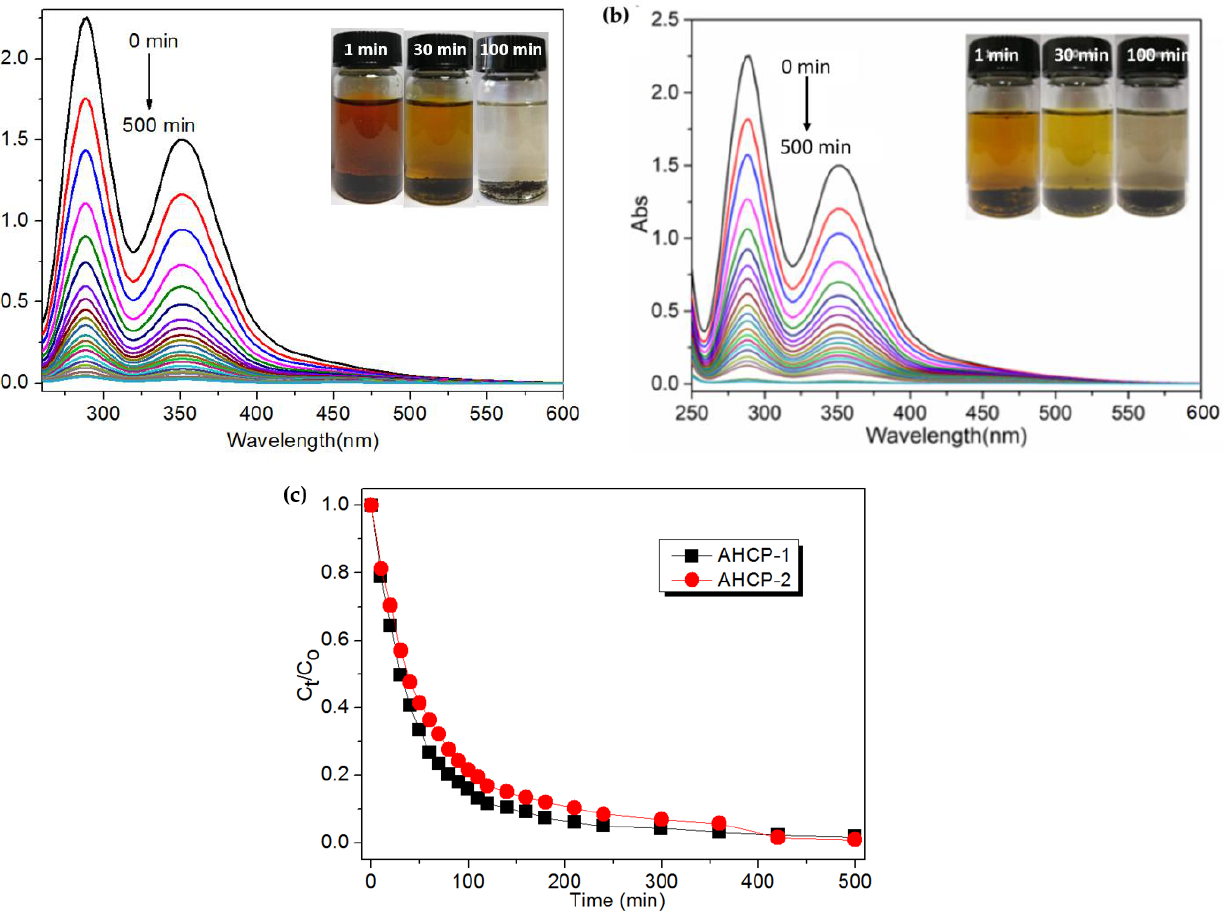
Figure 2. Time-dependent UV − vis adsorption spectra of the iodine aqueous solutions (150 µ M, 100 mL) in the presence of ( a ) AHCP-1 and ( b ) AHCP-2 at different intervals. Insets: photographs show color change of iodine enrichment at various times. ( c ) Iodine capture efficiencies at various times of AHCP-1-2 from water monitored by UV – vis at 288 nm.